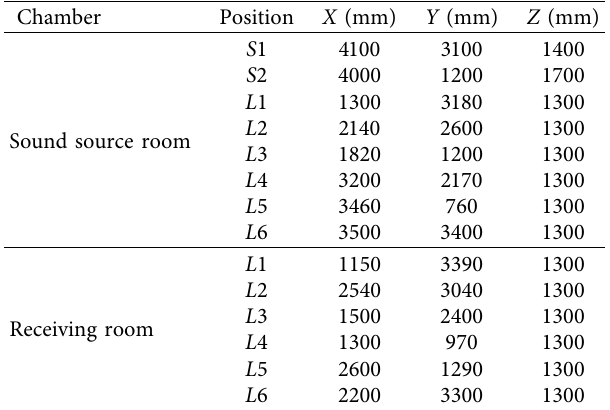
Table 2: Coordinates of measurement points and sound source